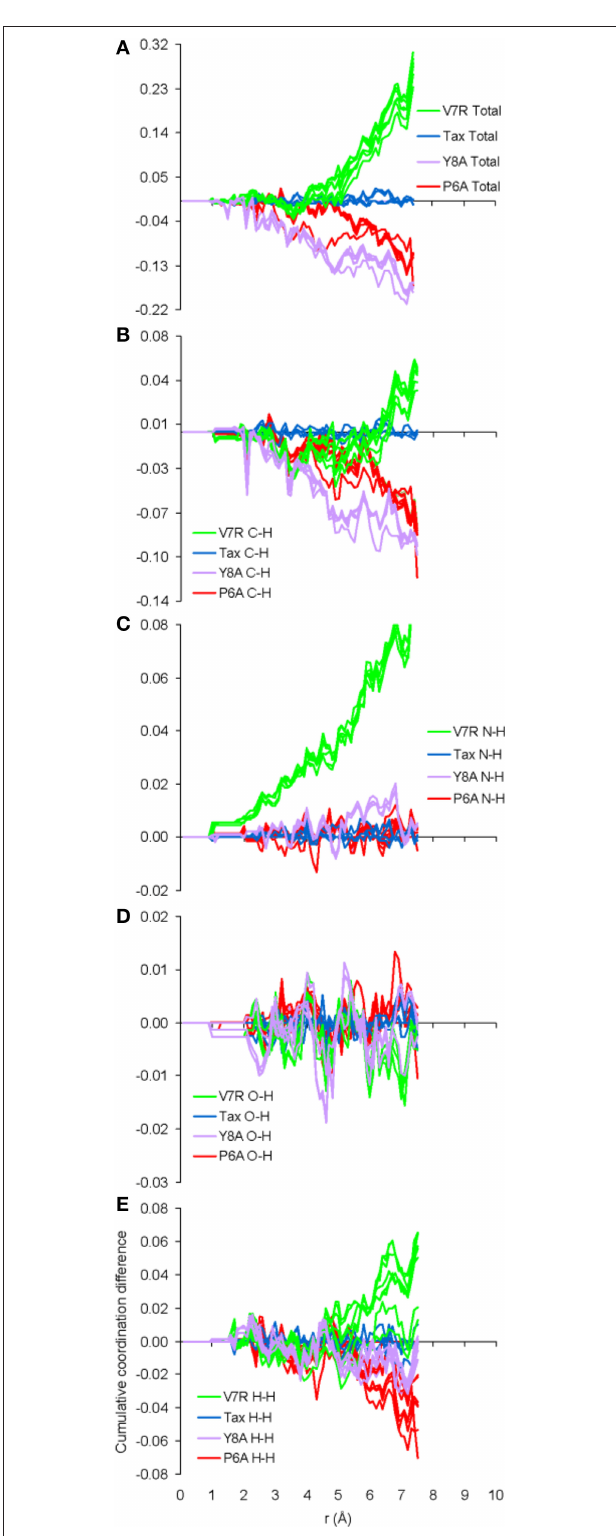
FIGURE 7 | Cumulative coordination difference of the partials of the H species for peptide protonated structures in respect to the charge-neutral spin-unpolarized Tax model. From (A–E) the total and C-H, N-H, O-H, and H-H partials,